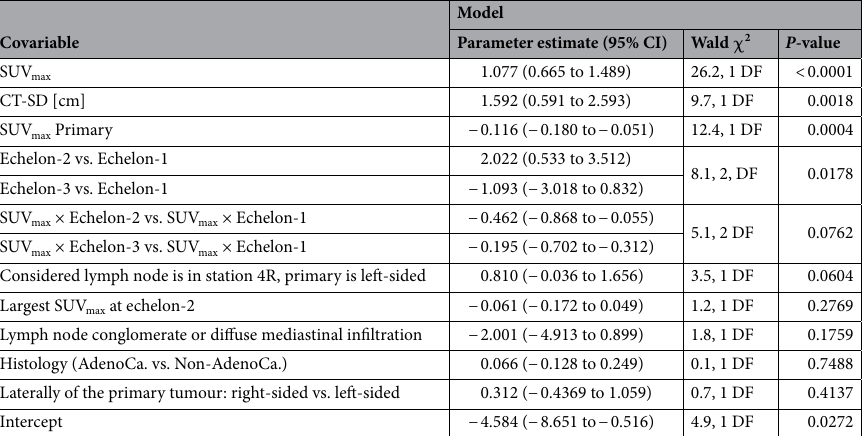
Model Parameter estimate (95% CI) Wald χ